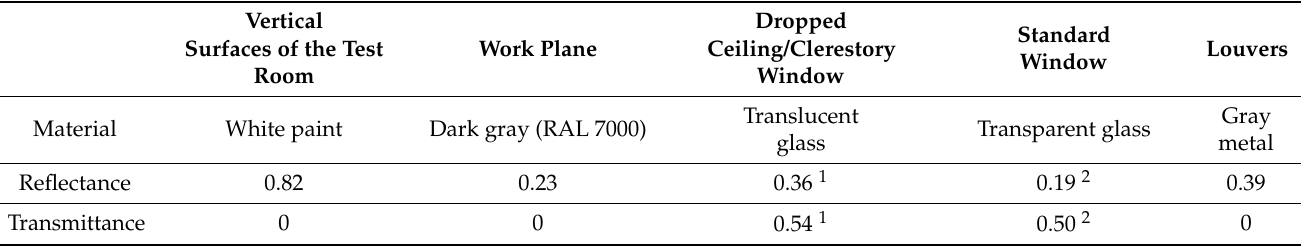
Table 2. Geometry characteristics per